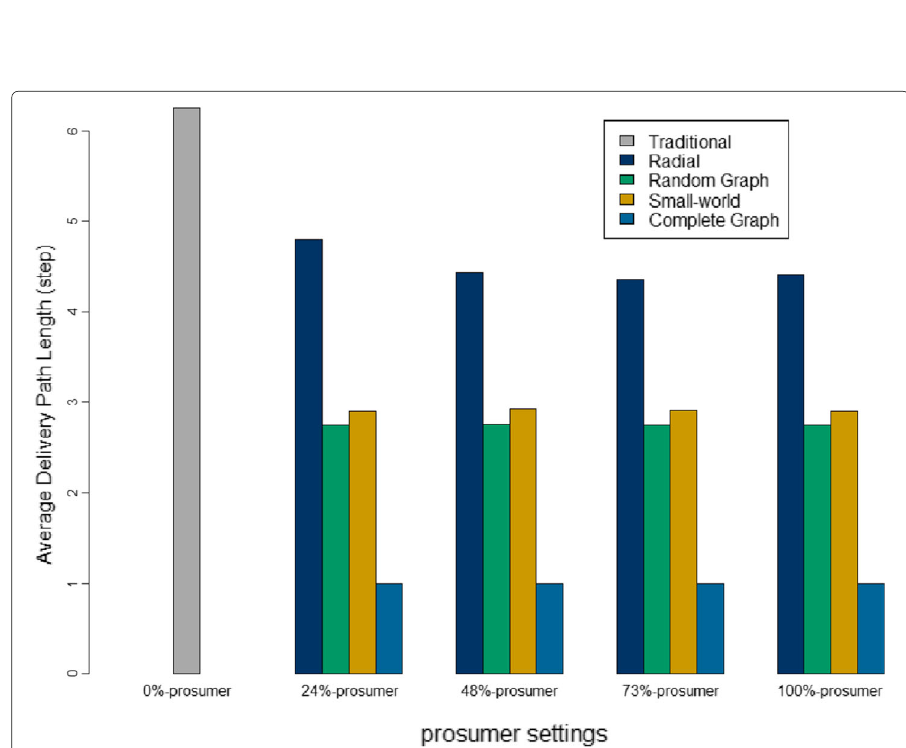
Fig. 6 Average delivery path